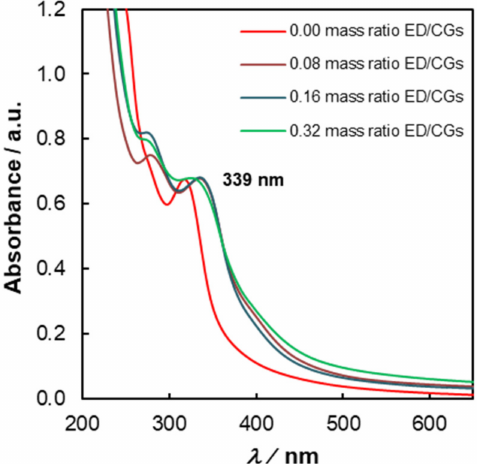
Figure 5. UV–Vis spectra of aqueous dispersions (0.1 mg/mL) of C-dots obtained from CGs with different amounts of ED and without additives (see Table